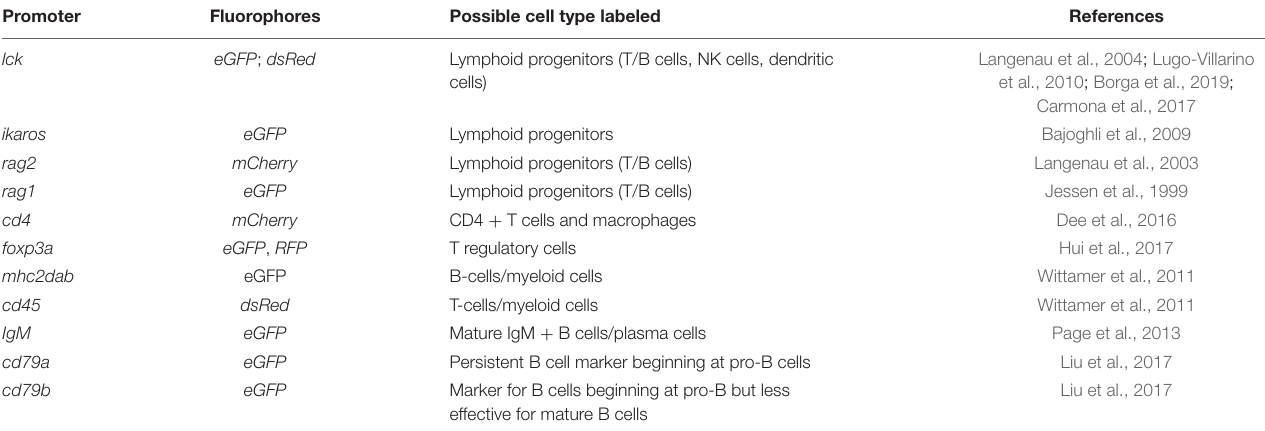
TABLE 1 | Transgenic fluorescent reporter lines for tracking adaptive immune cells.